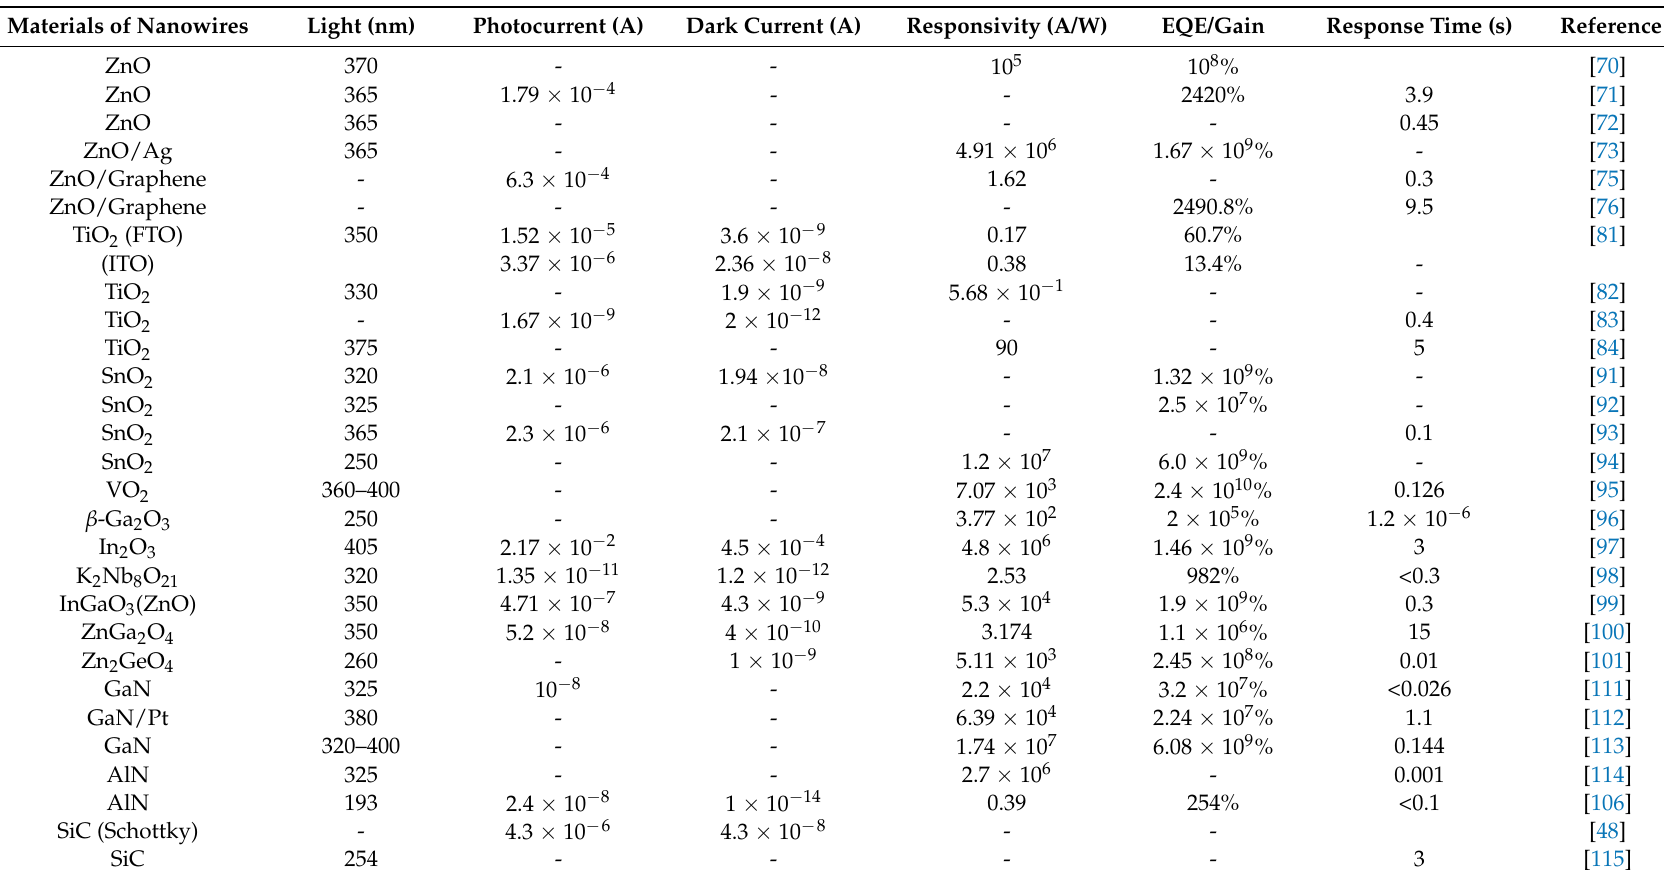
Table 2. The important parameters of UV detectors